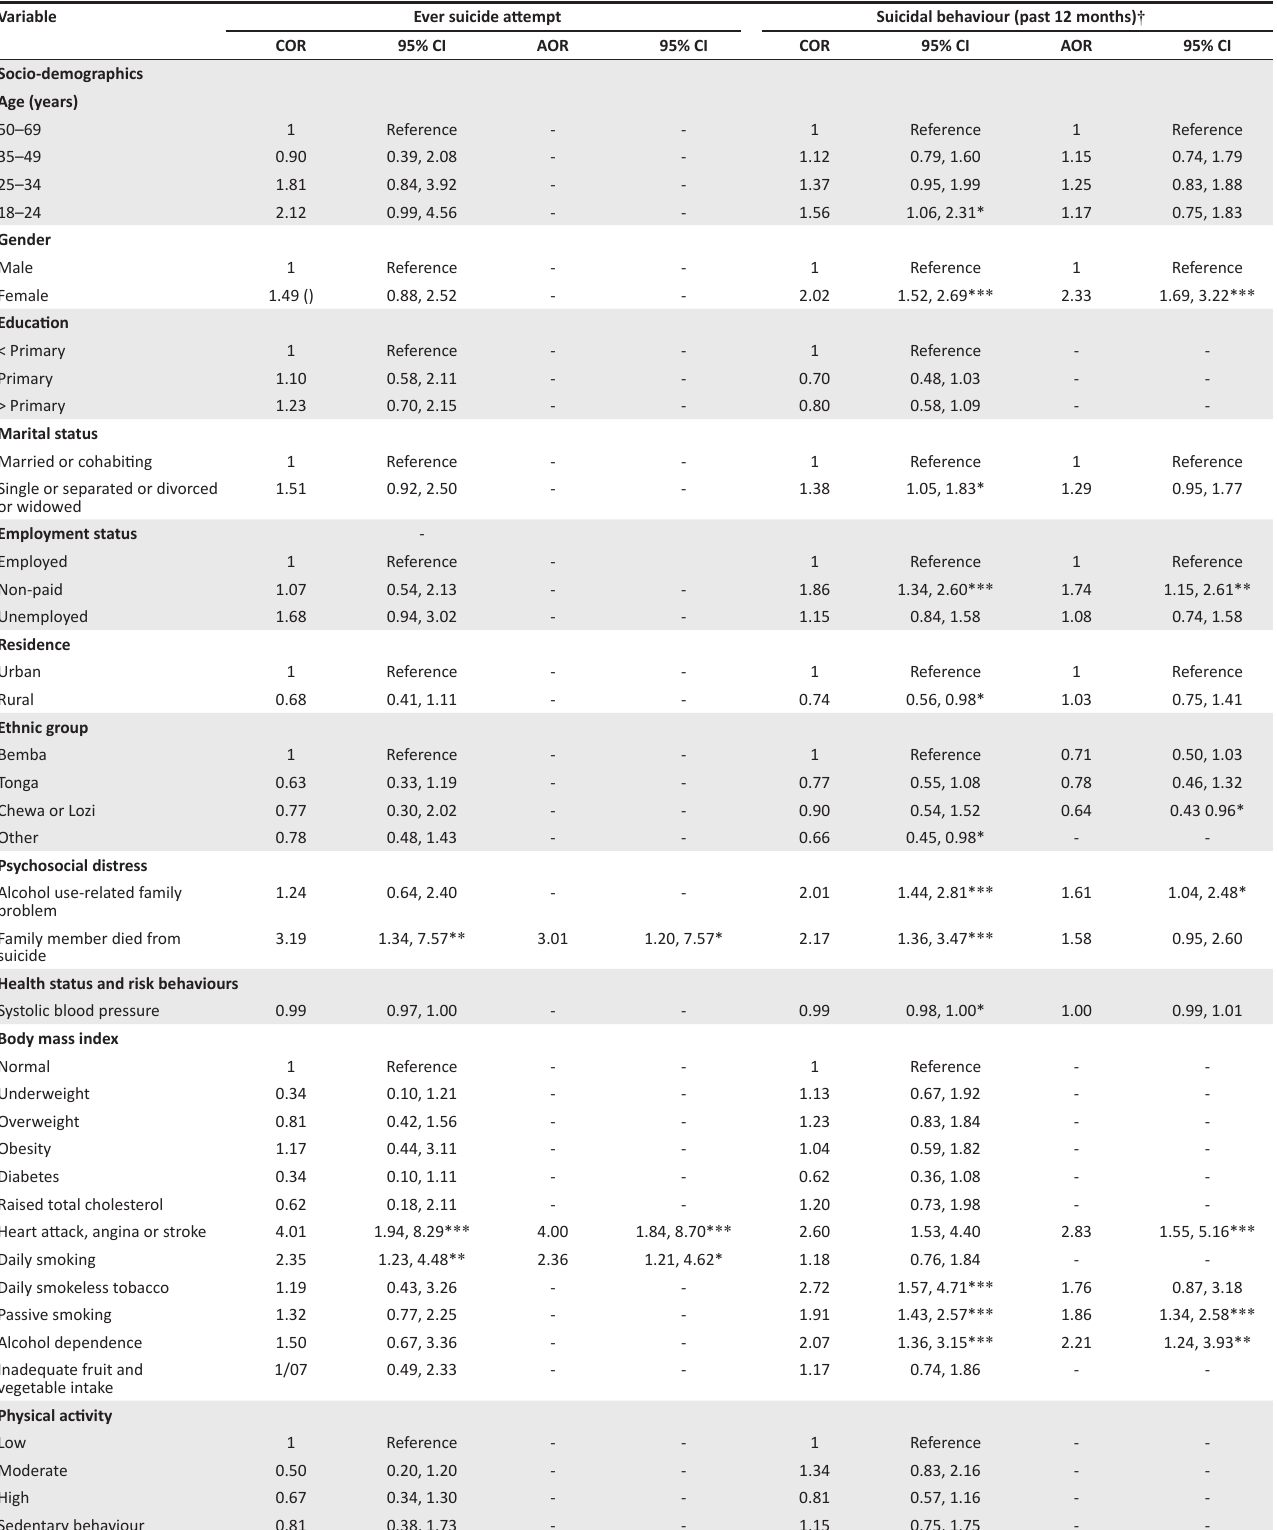
TABLE 2: Associations with ever suicide attempt and past 12-month suicidal behaviour.